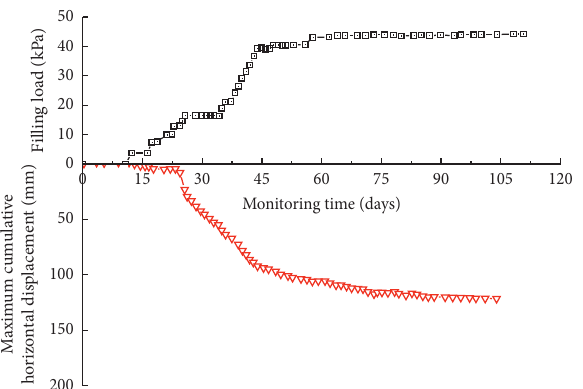
Figure 21: Variation of maximum cumulative horizontal dis- placement with filling